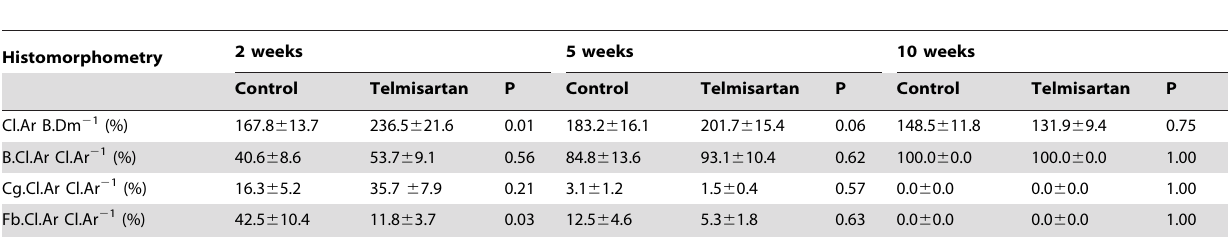
Table 2. Histomorphometric analysis of the callus of telmisartan-treated and vehicle-treated animals at 2, 5 and 10 weeks after fracture